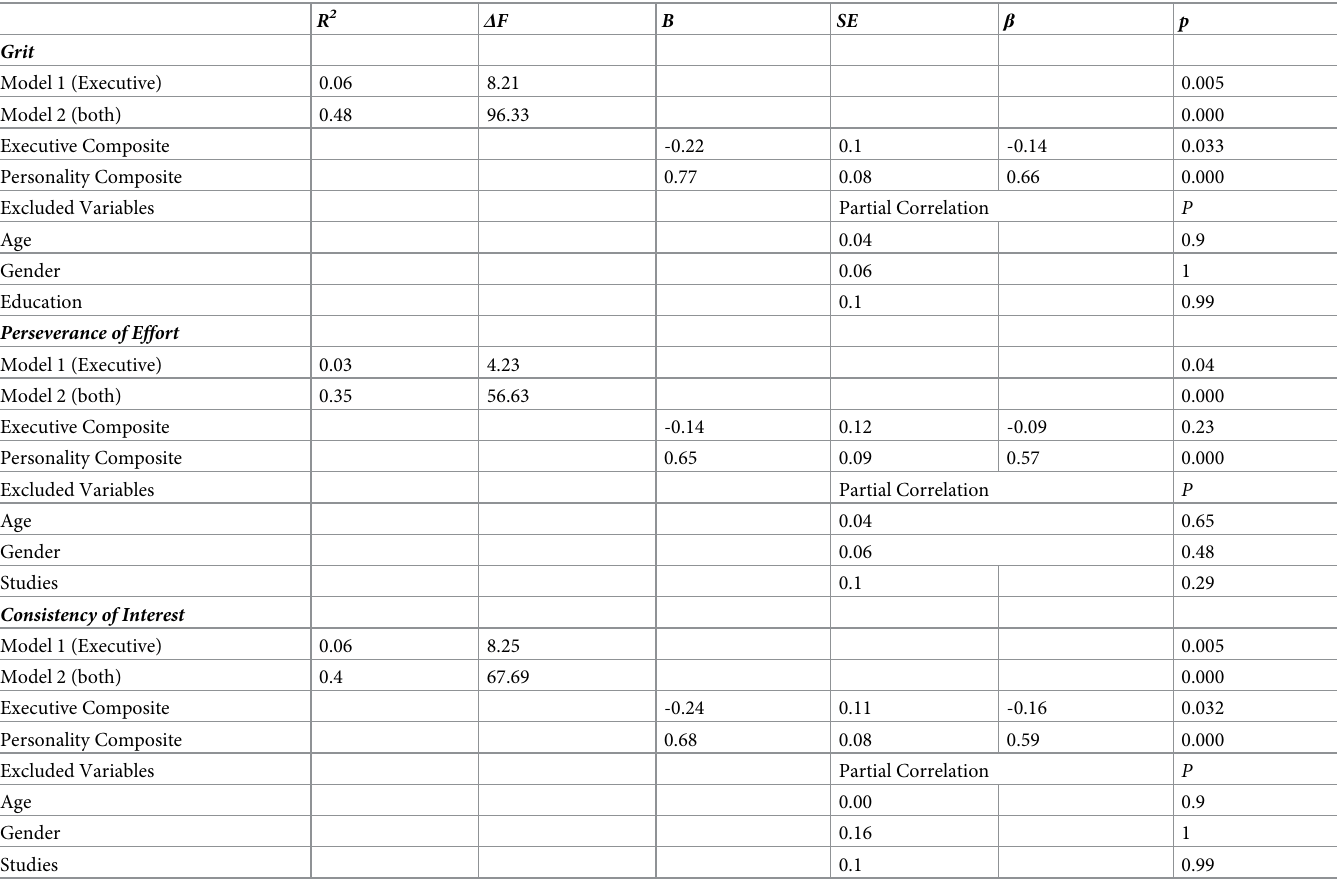
Table 4. Stepwise regression analysis of executive and personality composite scores over grit and its facets controlling for demographic